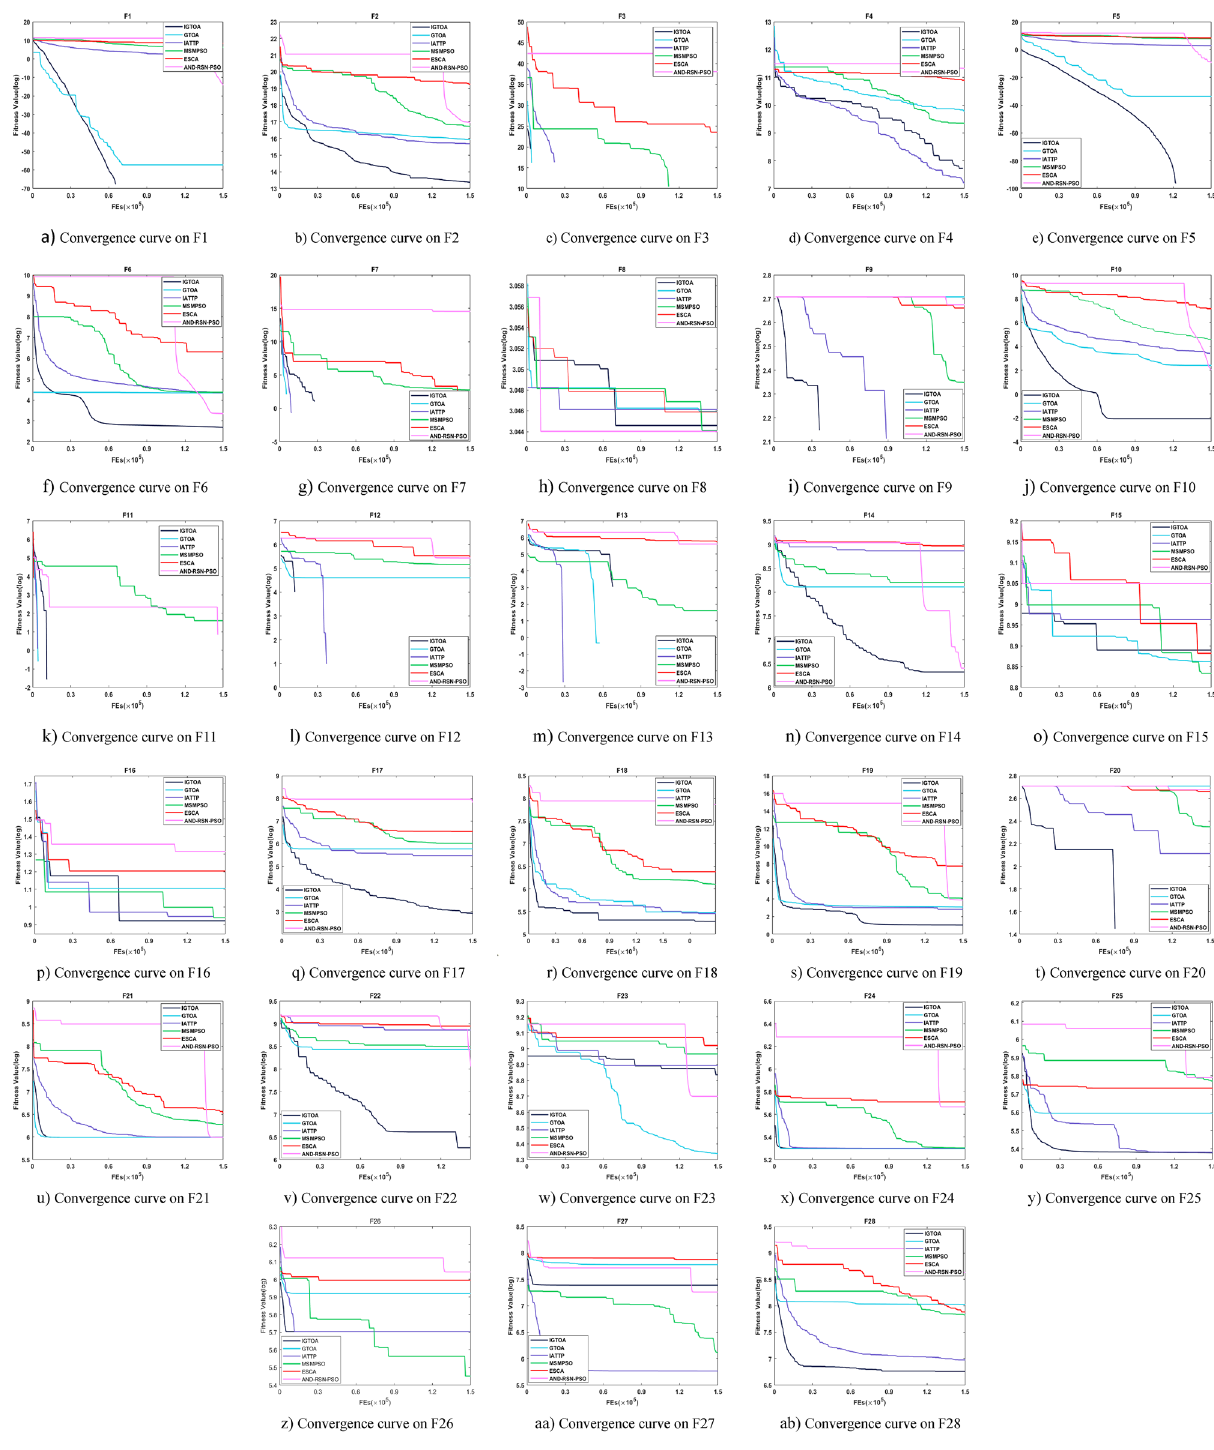
Figure 8. Convergence curves of each algorithm on the test